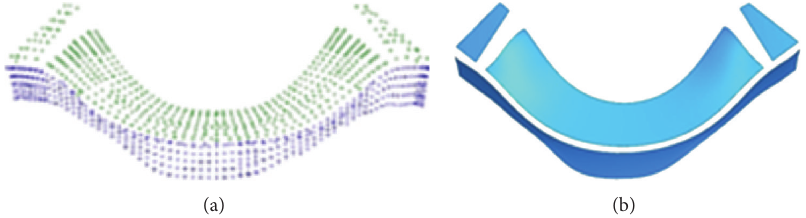
Figure 12: Point cloud and patches. (a) Measured points by CMM. (b) Patches by fitting the point